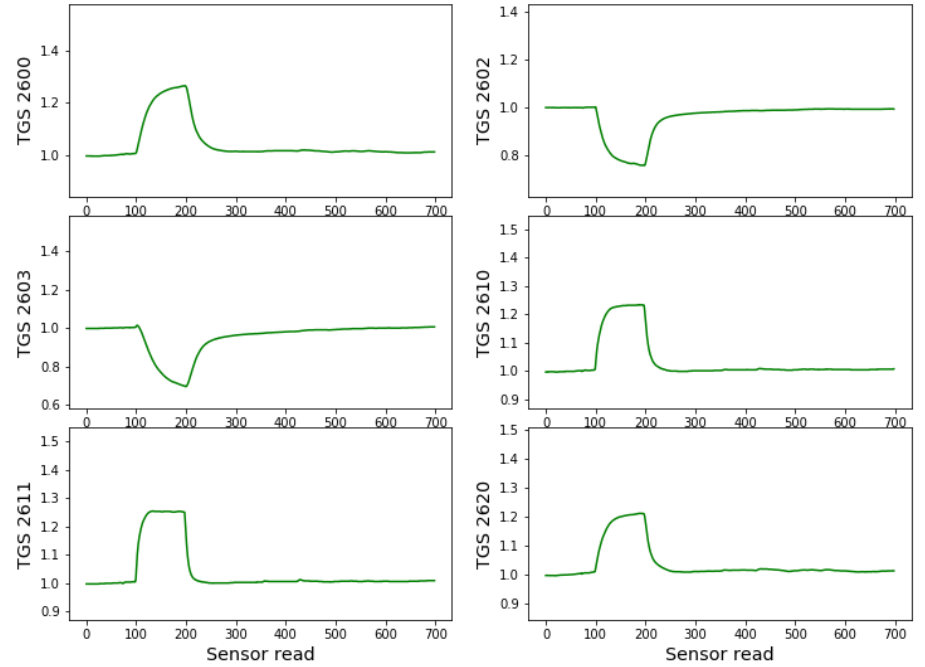
Figure 2. Example of the sensors’ responses (conductance) during one measurement cycle of a sample of healthy acorns. On the x-axis, the number of individual reads of the sensor resistance is used. The sensor data are collected every 1.2 s. The sensors responses are standardised by the baseline value obtained as the average of the first 100 reads of sensors values when sensors were exposed to the clear air